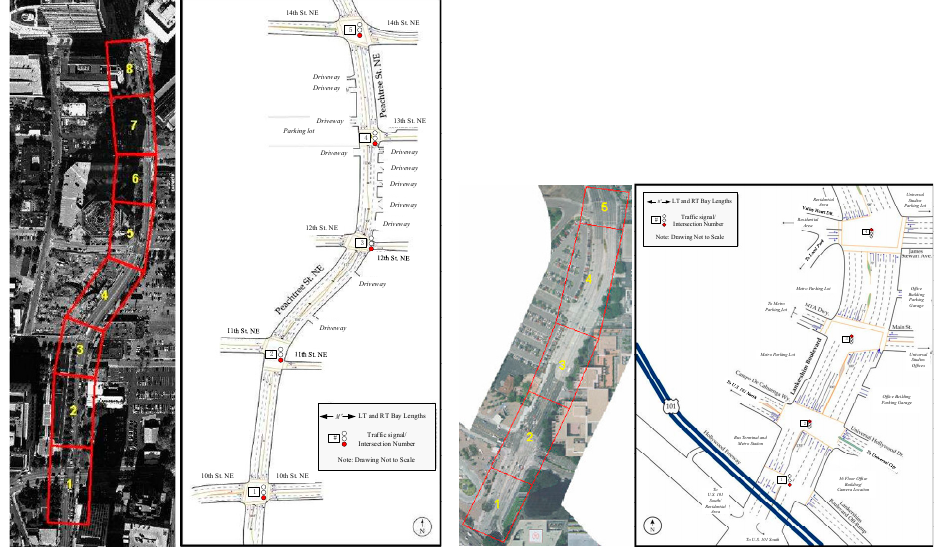
Figure 5. ( a ) Lankershim Boulevard. ( b ) Peachtree